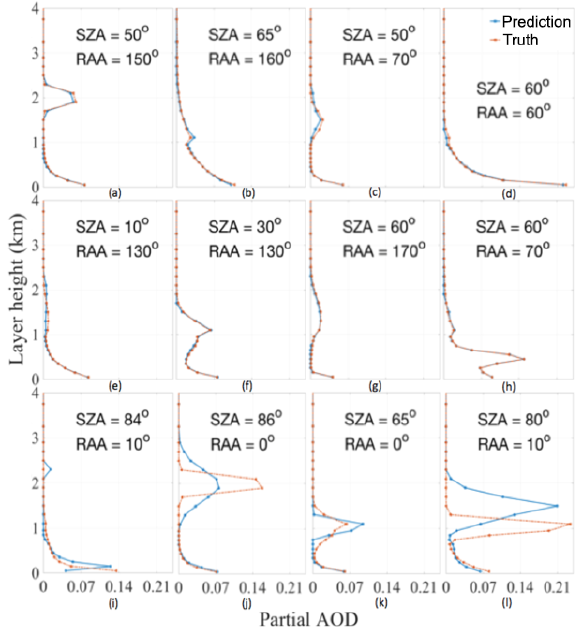
Figure 14. Examples of predicted partial layer AOD profiles: (a– h) randomly selected examples and (i–l) bad predictions.